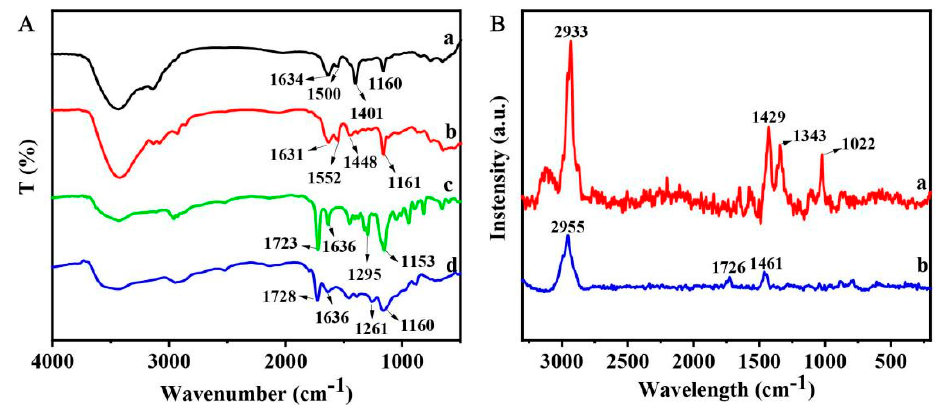
Figure 1. ( A ) FT-IR spectra of [V 2 C 4 (mim) 2 ]Br 2 (a), poly([V 2 C 4 (mim) 2 ]Br 2 ) (b), EGDMA (c), and poly(EGDMA) (d). ( B ) Raman spectra of poly([V 2 C 4 (mim) 2 ]Br 2 ) (a) and poly(EGDMA) (b).